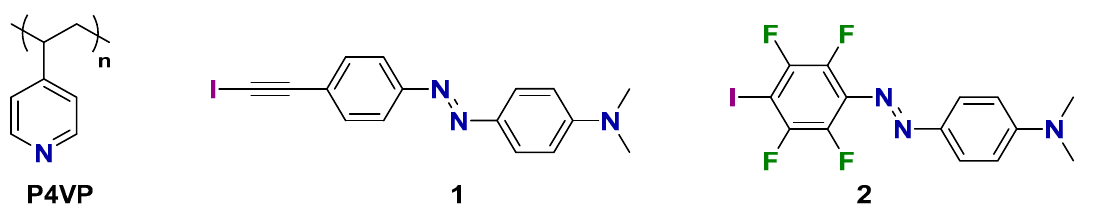
Figure 1. Chemical structures of the halogen-bond-accepting polymer (P4VP) and the halogen-bond-donating azobenzene derivatives (Molecules 1 and 2 ) used in this work.